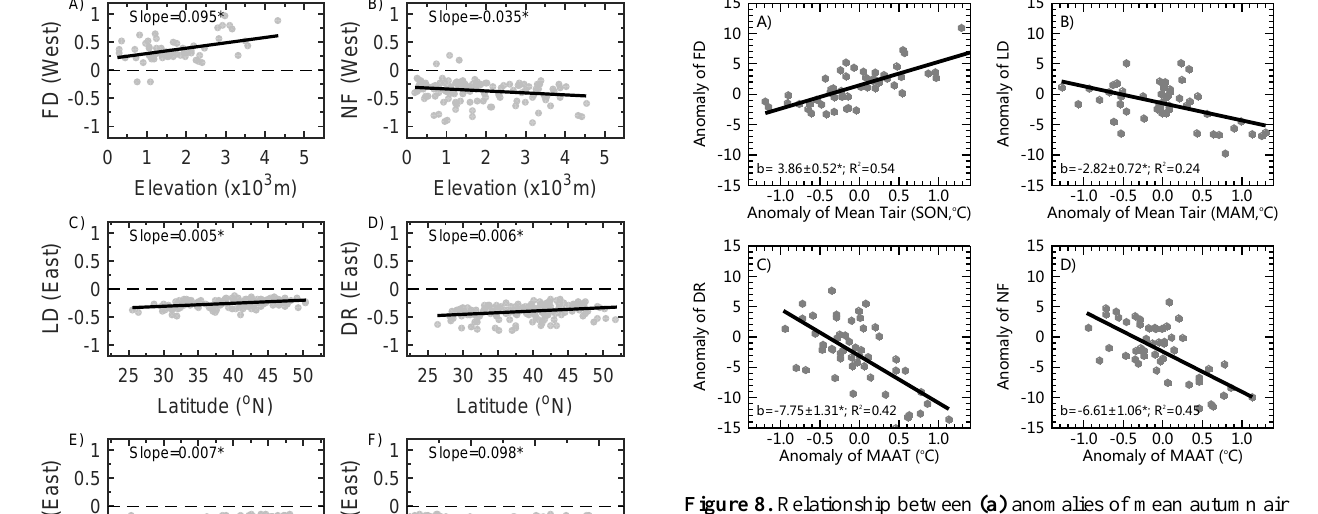
Figure 8. Relationship between (a) anomalies of mean autumn air temperature (September through November) and the first date (FD), (b) anomalies of mean spring air temperature (March through May) and the last date (LD), (c) anomalies of mean annual air temper- ature (July through June in the next year) and duration (DR), and (d) number of days (NF) from 1956 through 2006 across China. All regression lines have a statistically significant trend with at least a 95% confidential level.